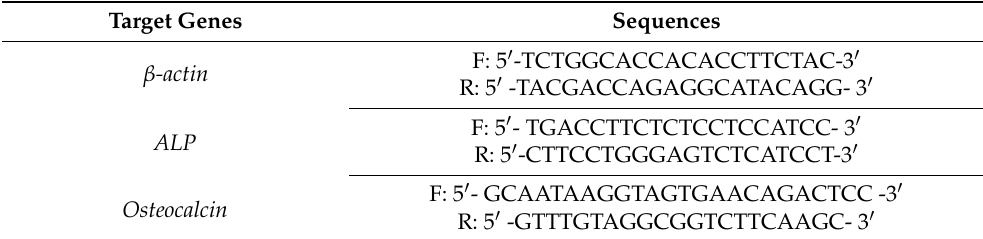
Table 4. List of primer sequences used for polymerase chain reaction (PCR) analysis.